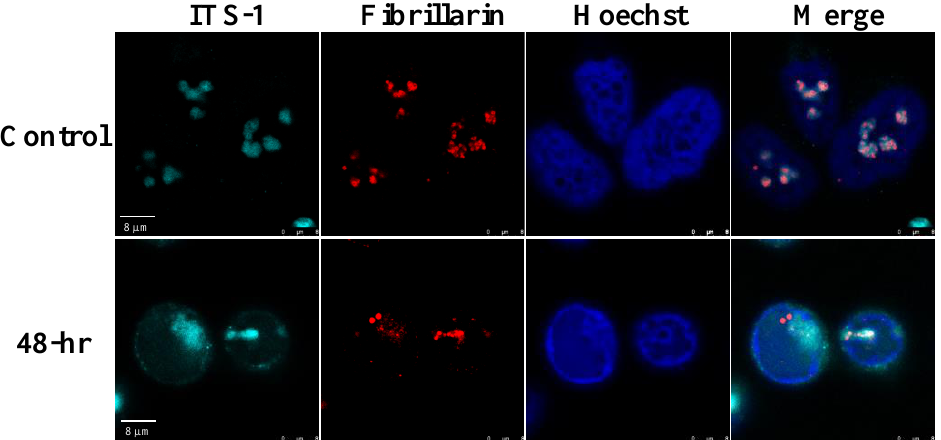
Figure 8. RNA in situ hybridization analysis to determine the location of the pre-rRNA transcripts and Fibrillarin in cells during viral lytic reactivation. SLK and BAC16-infected iSLK cells were treated with 1µg/mL Dox and 1 mM n-Butyrate. Cells were incubated with ITS-1 probe and stained with anti-Fibrillarin and Cy3-conjugated secondary antibody. Hoechst staining was used to detect chromatin.